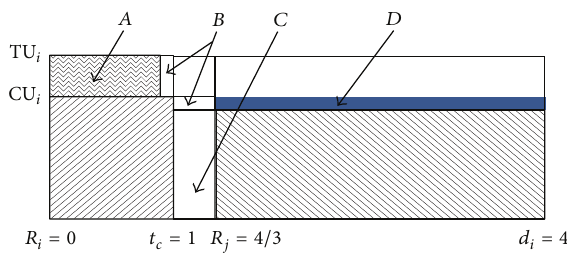
Figure 6: Slack exchange process for idle period.